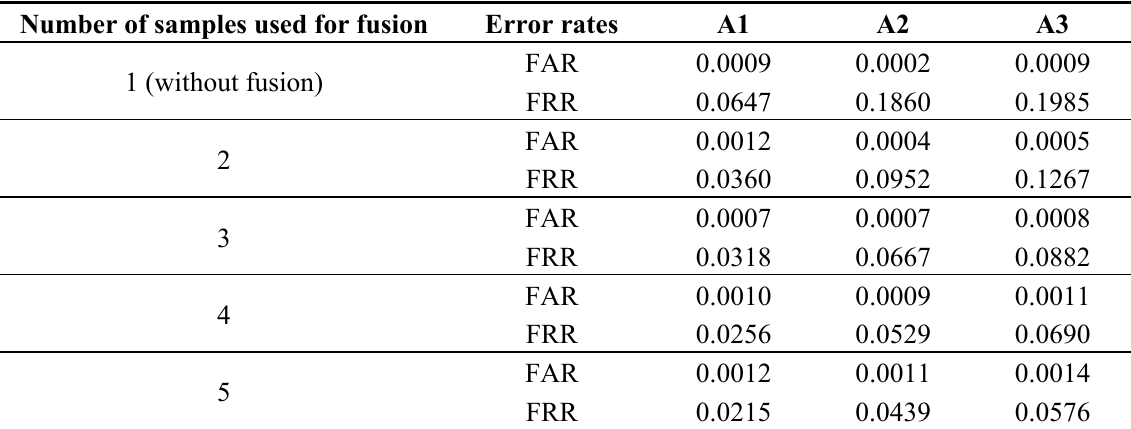
Table 3. Best performance (operation points closest to the performance target FRR ≤ 0.01 @ FAR = 0.001)—multi-sample